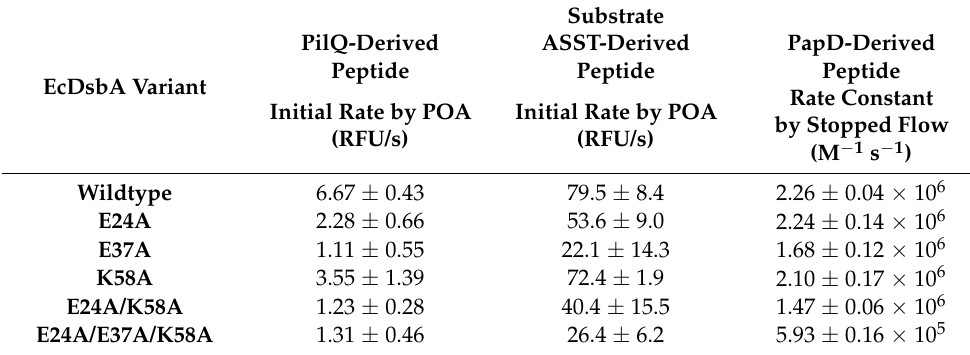
Table 2. Kinetic parameters of DsbA mutants. Initial rate and rate constants are expressed as mean ± standard error of the mean (SEM) with at least three independent